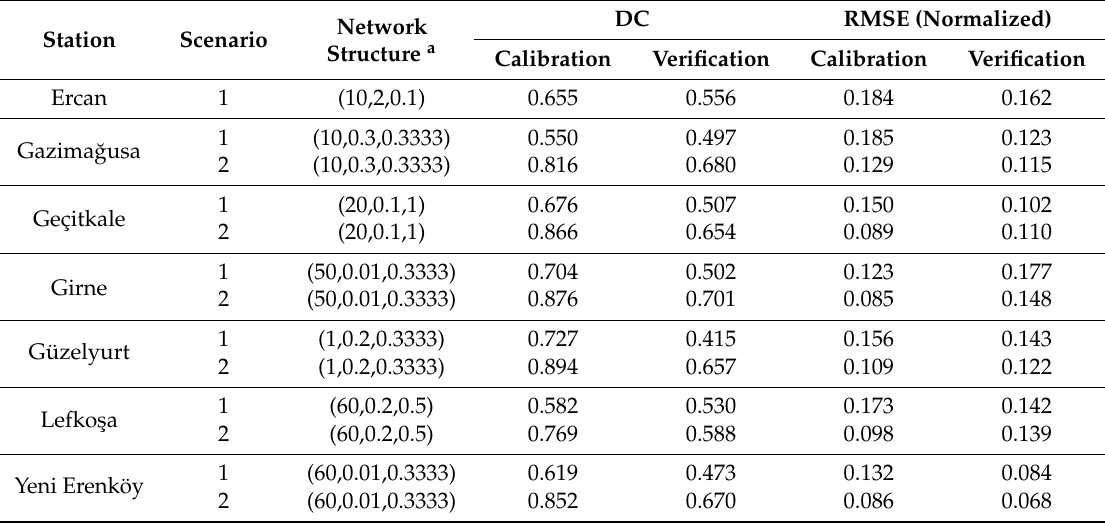
Table 6. Results of monthly rainfall predictions by LSSVM for both scenarios 1 and